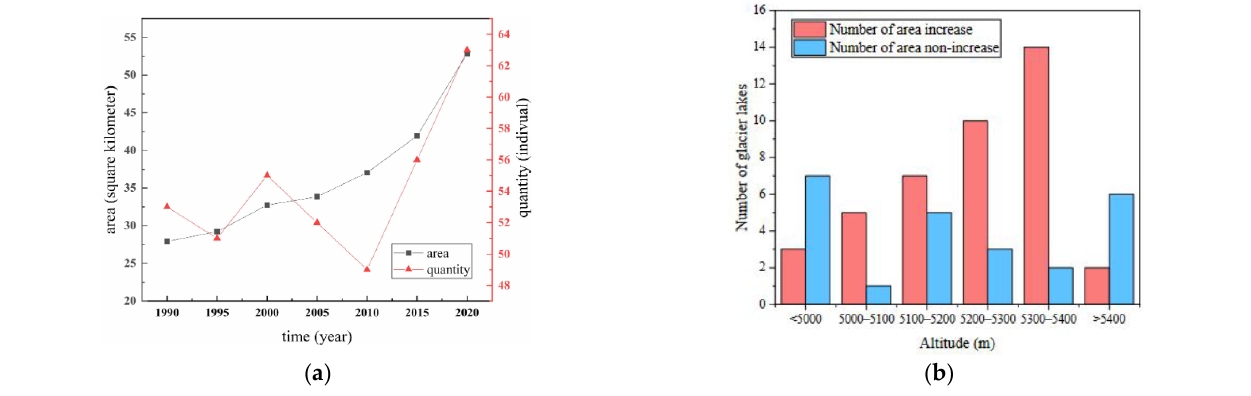
Figure 4. Changes in the number and area of glacial lakes from 1990 to 2020. ( a ) Changes in the number and area of glacial lakes from 1990 to 2020; ( b ) Changes in the number of area increases in glacial lakes from 1990 to 2020. Table 2. Changes in the number and area of glacial lakes from 1990 to 202 0.